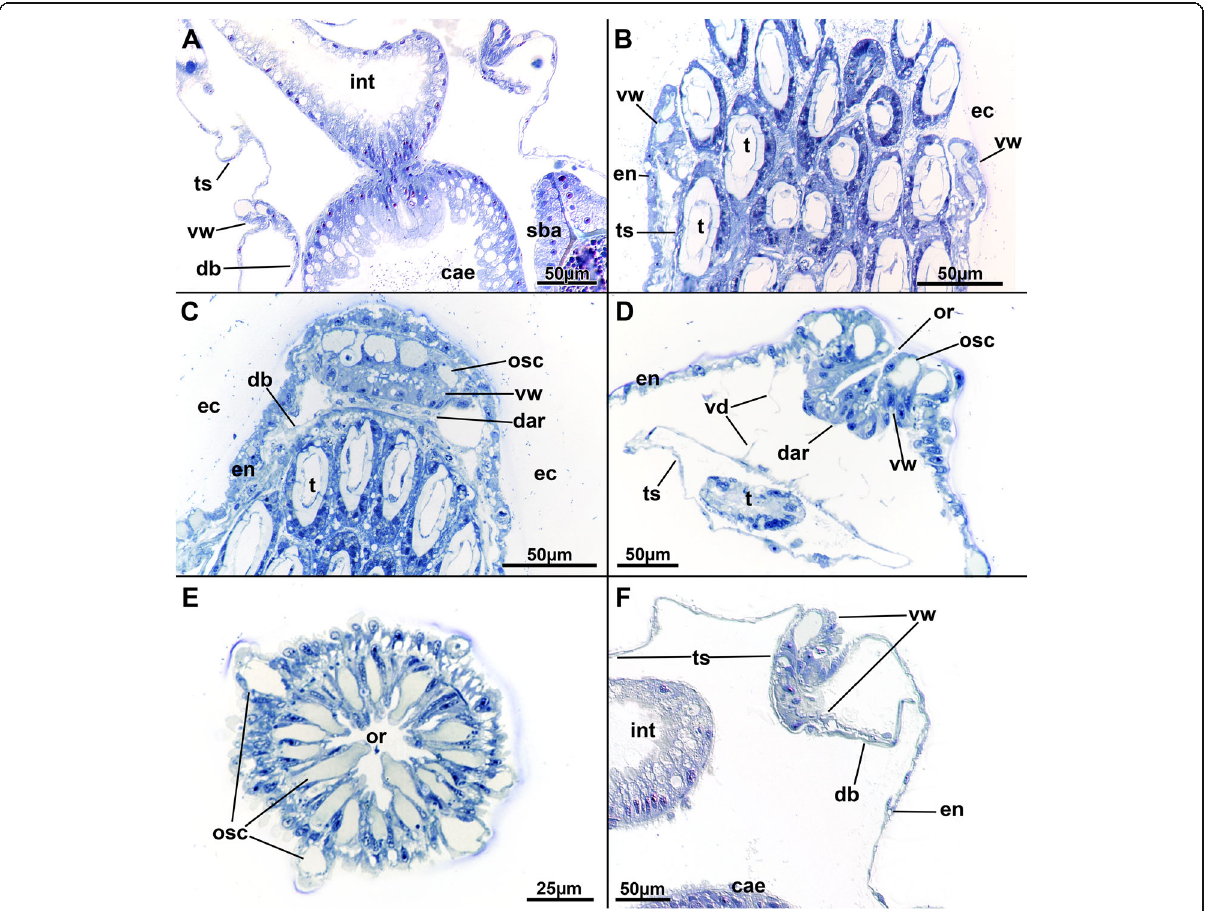
Fig. 3 Histological details of the vestibular area of Stephanella hina . Semithin sections. a Longitudinal section of an extended polypide. b Oblique section of a slightly extended specimen showing the apertural area. c Longitudinal section through the vestibular wall of a zooid with retracted polypide showing the dense glandular/sensory (?) orificial cells. d Median longitudinal section of the apertural area of a zooid with retracted polypide. e Cross-section of the folded vestibular wall with contracted vestibular wall musculature. f Close-up of the vestibular wall of a protruded specimen (compare to A). Abbreviations: cae - caecum, dar - diaphragmatic area, db - duplicature band, ec - ectocyst, en - endocyst, int - intestine, or - orifice, osc – orificial (sensory?) cells, sba - statoblast anlage, t - tentacle, ts - tentacle sheath, vd - vestibular dilatators, vw